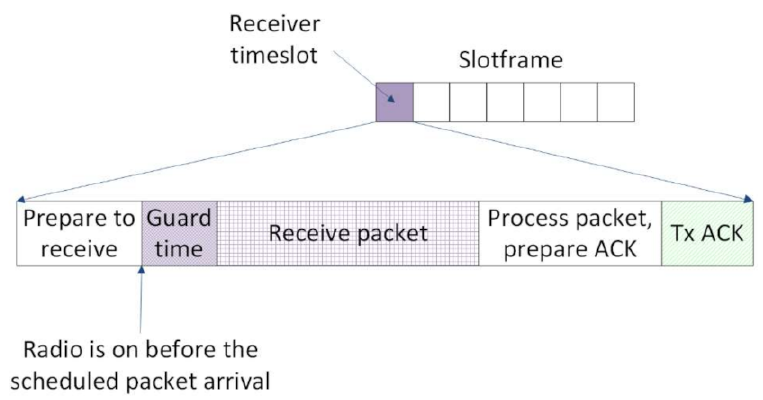
Figure 7. TSCH timeslot template for a receiver node. ACK: acknowledge